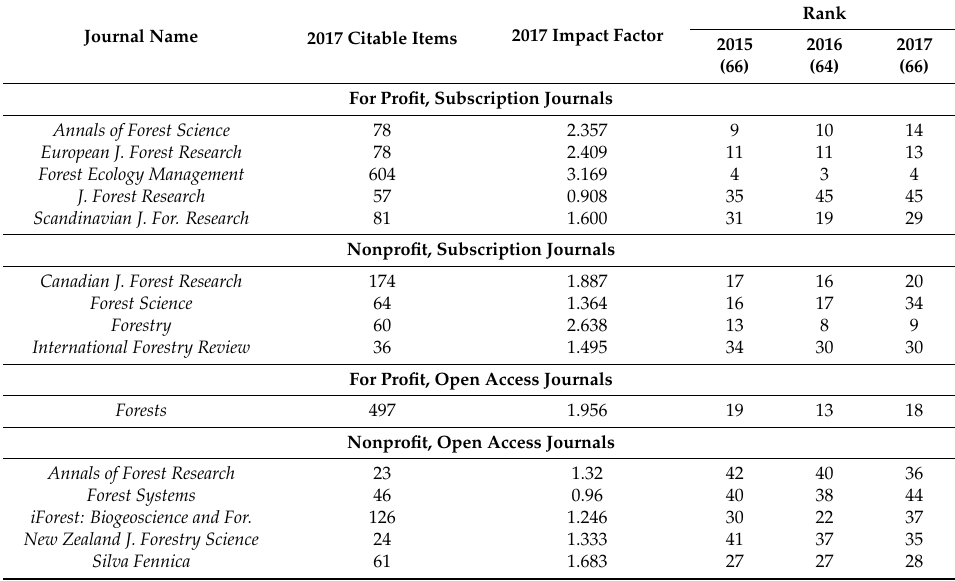
Table 2. Total citable items for all “forestry” data, and 2017 data for general forest science journals. Rankings for from 2015–2017 with total journals in